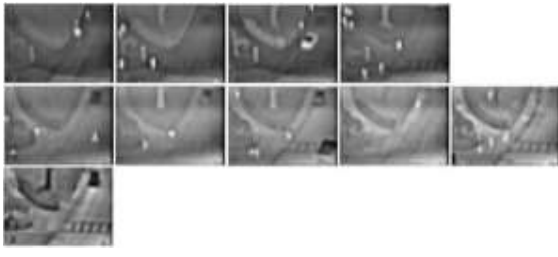
Figure 6. First low pass sub-bands for first image of each set of OSU thermal dataset.